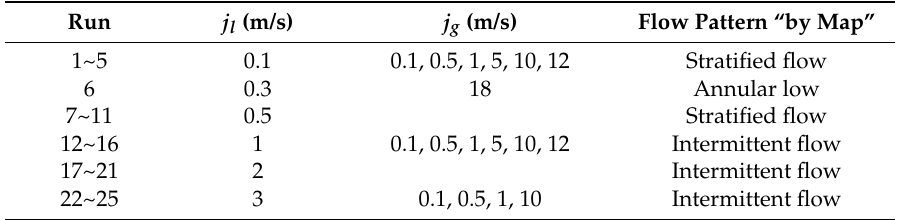
Table 5. Test matrix for air-water two-phase flow experiments in the inclined